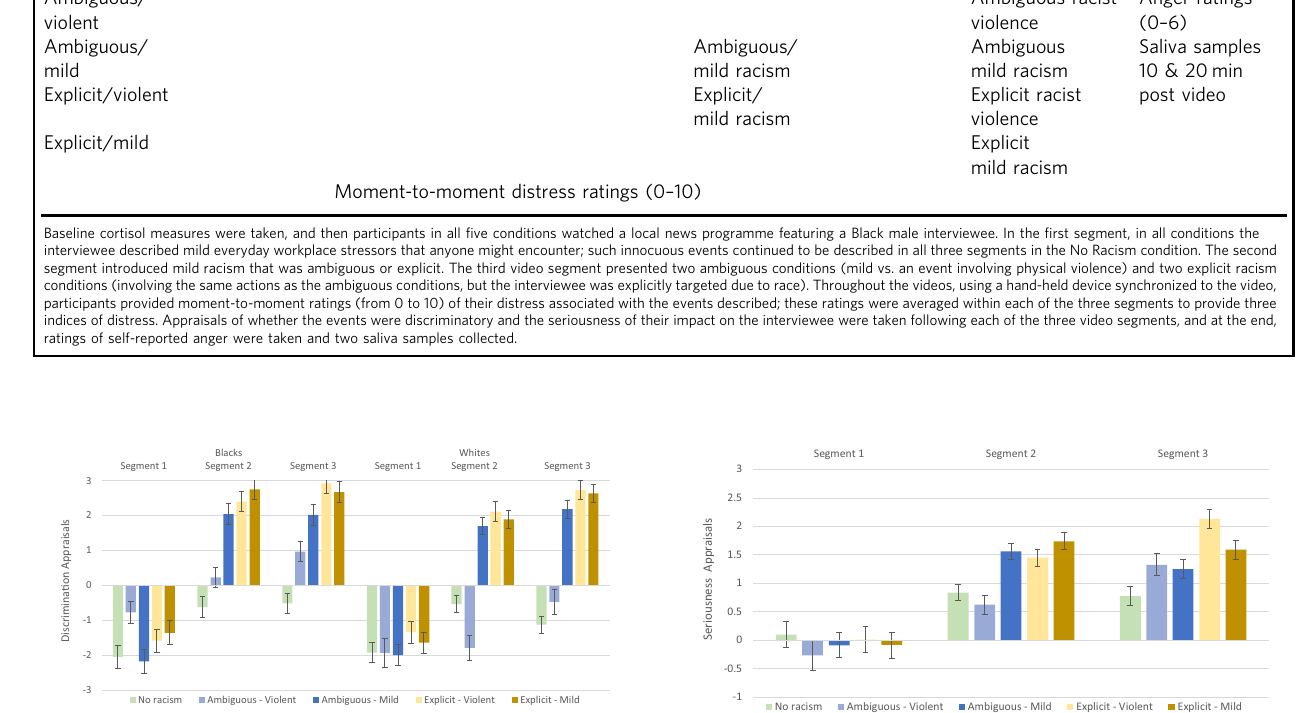
Fig. 2 Mean ratings ( + se ) of discrimination appraisals as a function of racist cues ( fi ve conditions) in the three video segments among Black (left) and White (right) participants. There were no differences in appraisals of discrimination in Segment 1. The second segment introduced ambiguous mild racism in the relevant condition, and explicit mild racism in two of the conditions (labelled explicit mild and explicit violent), at which point greater discrimination was perceived in these three conditions, particularly among Blacks. By the Segment 3, in which conditions involving physical violence were introduced, both Blacks and Whites were more likely to perceive the conditions involving explicit racist cues as discriminatory, irrespective of the presence of violence. When cues were ambiguous, participants were less likely to appraise the violent situation as discriminatory, particularly among Whites. irrespective of the presence of violence, t (200) = 0.53, p = 0.60.